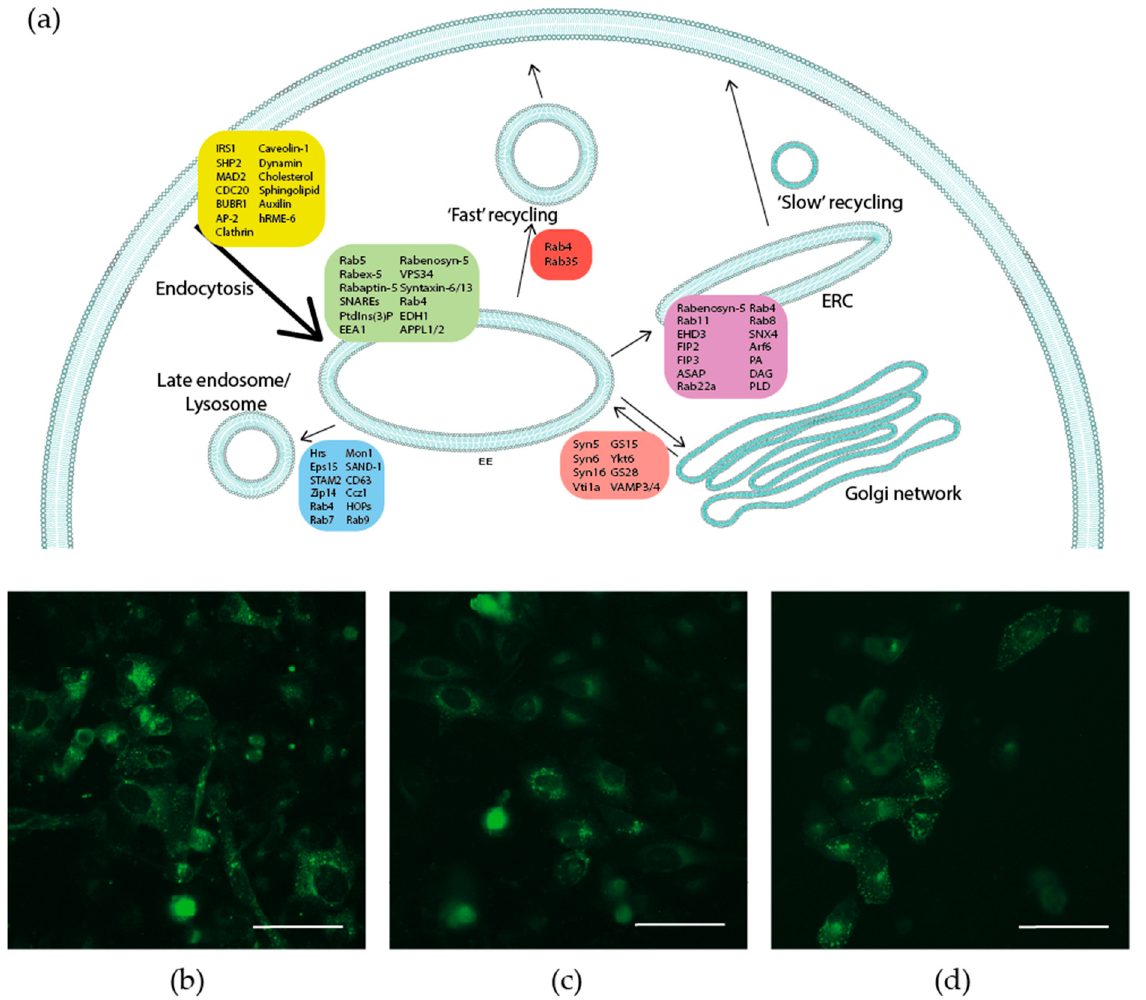
Figure 2. Distribution of endosomal compartments. ( a ) Diagram representing the different endosomal compartments and the proteins that can be found in them (EE, early endosome; ERC, endosomal recycling compartment). Below, human osteosarcoma U2OS cells transfected with GFP-tagged versions of ( b ) Rab5B, a gift from Gia Voeltz (Addgene plasmid #61802 [44] ); ( c ) Rab7; and ( d ) Rab11, both gifts from Richard Pagano (Addgene plasmid #12605 and #12674, respectively [45] ). Stably transfected cells were selected in the presence of gentamycin (500 µg/mL), and the cellular localisation of the different Rab isoforms was visualised with an EVOS FLoid microscope. Bar: 100 µm.